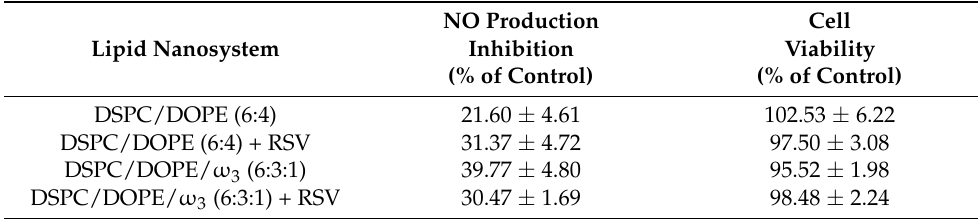
Table 2. Effects of liposome formulations on nitric oxide (NO) production by RAW264.7 macrophages stimulated with lipopolysaccharide (LPS). NO Lipid Nanosystem